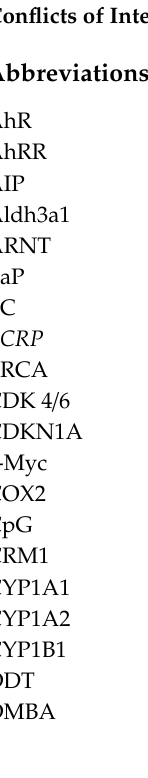
Figure 3. AhR pathway interactions in cancer breast cells. AhR is usually overexpressed in cancer breast cells. Here, it correlates with several markers of: 1. proliferation (NF- κ B, IL6, c-Myc, BRCA1); 2. DNA repair (BRCA genes); 3. cell migration (Kyn) 4. metastatic behavior (MMPs and PLAU); 5. immune system (Th 17 and T reg cells); 6. Inflammation (NF- κ B, IL6, Kyn); BRCA = BReast CAncer gene; Kyn = Kynurenine; c-Myc = Avian myelocytomatosis virus oncogene cellular homolog; IL-6 = interleukin 6; MMP = matrix metalloproteinase; NF-kB = nuclear factor kappa-light-chain-enhancer of activated B cells; PLAU = Plasminogen Activator, Urokinase (gene); ↑ = increase; ↓ = decrease.